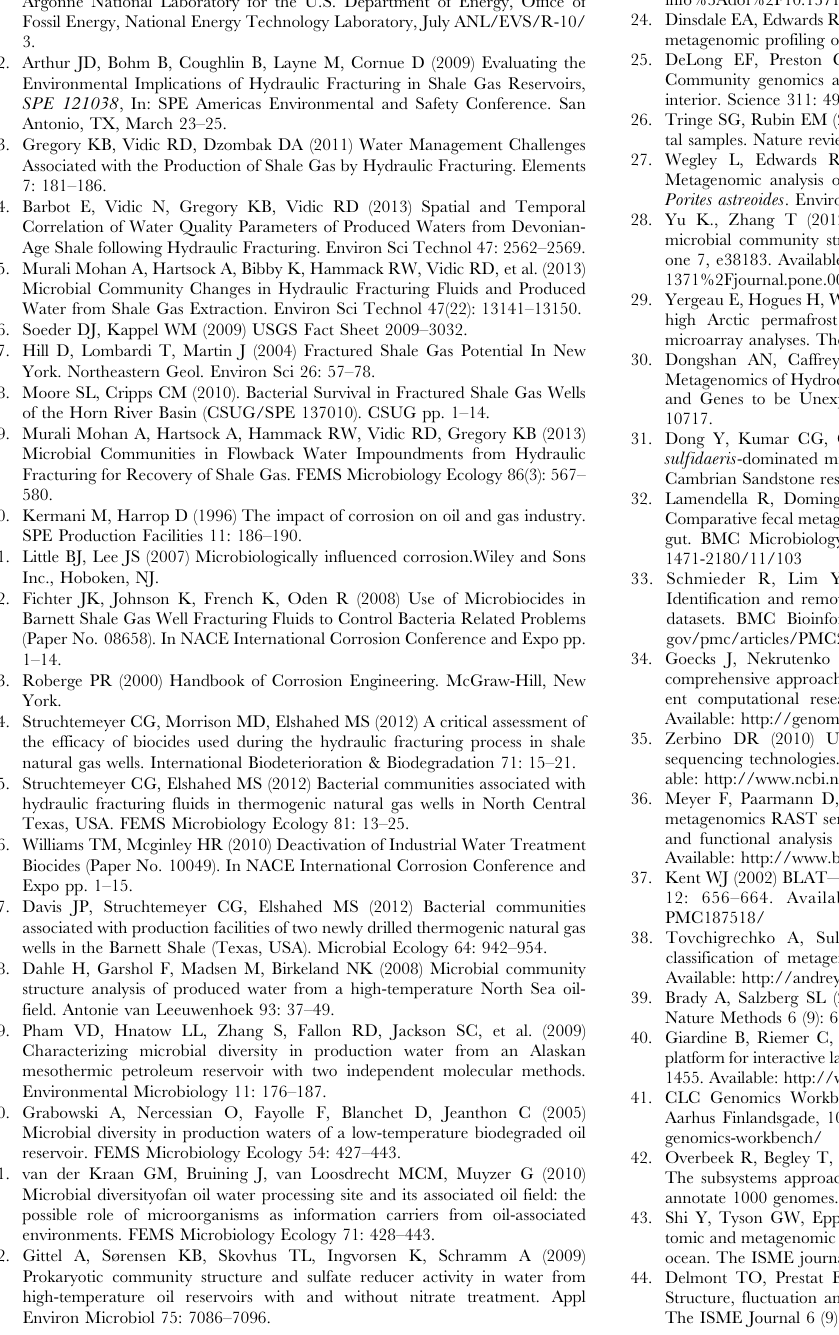
using CLC Genomics Workbench version 6.5.1 with default